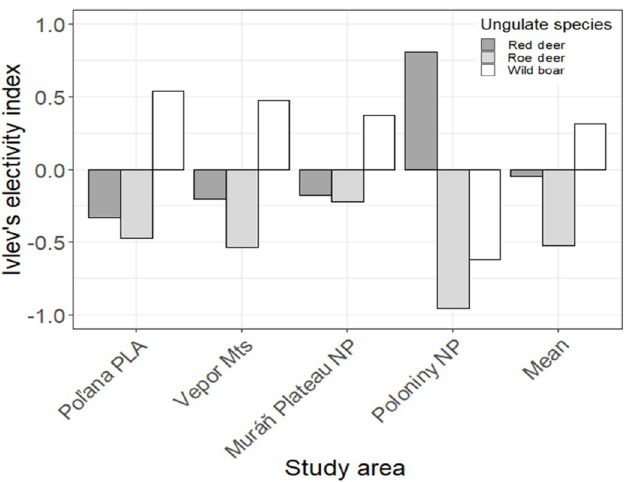
Fig 3. Prey electivity. Prey electivity (Ivlev’s index) for the main three wild ungulates, according to the biomass consumed by wolves and the biomass available in each of the study areas in the Slovak Carpathians.